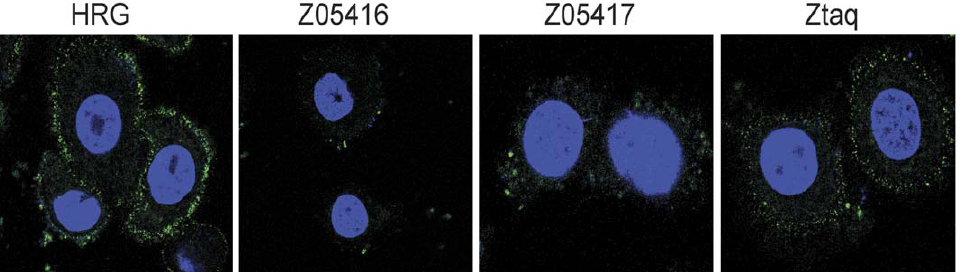
Figure 3. Competitional binding between the natural ligand HRG and Affibody molecules to the HER3-positive breast cancer cell line AU565 visualised by confocal microscopy. AU565 cells were pretreated with Affibody molecules (Z05416, Z05417 or ZTaq) or PBS only (HRG) before addition of HRG in conjugation with a fluorophore. HRG binding to cells is shown in green while nuclear staining by DAPI is shown in blue.